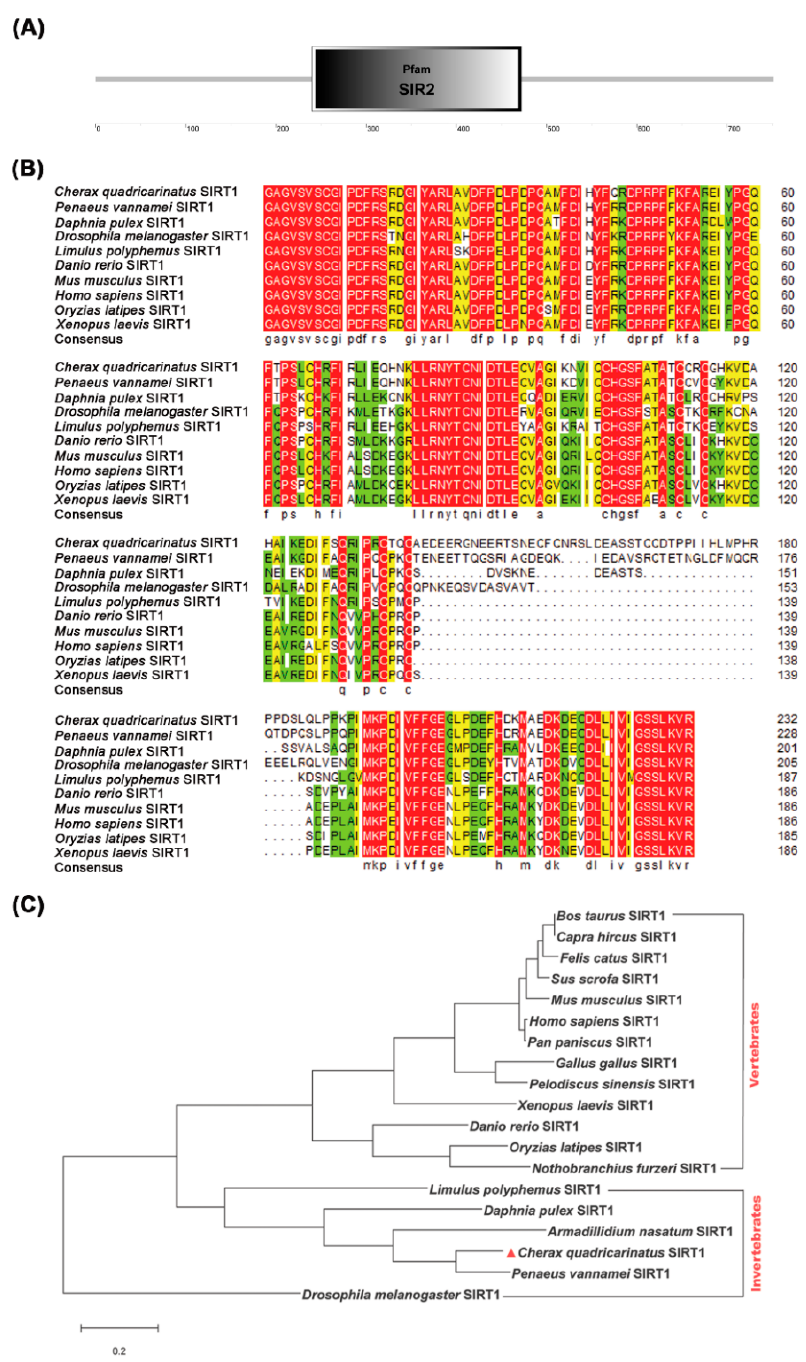
Figure 1. Molecular characteristics of Cq SIRT1 from red claw crayfish C. quadricarinatus . ( A ) Conserved domain analysis of Cq SIRT1. ( B ) Multiple sequence alignment of Cq SIRT1 based on deacetylase domains. ( C ) The phylogenetic tree of Cq SIRT1 homologs from several species based on complete amino acid sequences using the neighbor-joining method. Penaeus vannamei (XP_027218224.1), Armadillidium nasatum (KAB7503239.1), Daphnia pulex (XP_013777128.1), Limulus Polyphemus (XP_013777128.1), Drosophila melanogaster (AAF53248.1) , Danio rerio (XP_001334440.4), Mus musculus (AAI52315.1), Sus scrofa (NP_001139222.1), Bos Taurus (NP_001179909.3), Felis catus (NP_001277175.1), Gallus gallus (NP_001004767.1), Pelodiscus sinensis (XP_006125338.1), Pan paniscus (XP_003830353.1), Oryzias latipes (XP_004077552.1), Xenopus laevis (NP_001091195.1), Capra hircus (AKJ66821.1), Nothobranchius furzeri (ABX71822.1), Homo sapiens